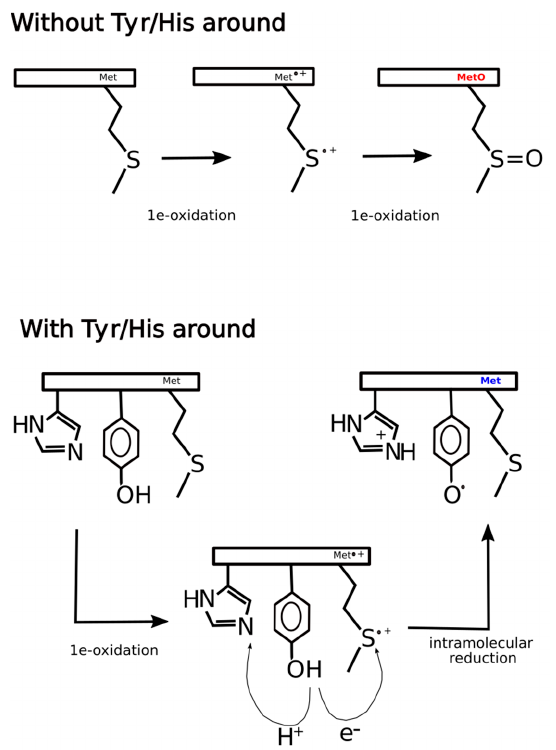
Figure 11. Hypothetical mechanism of ex vivo methionine oxidation. In the absence of tyrosine and histidine in the neighborhood of a given methionine residue, two consecutive one-electron oxidations lead to the formation of methionine sulfoxide. However, if tyrosine and histidine are present in the environment of the methionine site, after the first one-electron oxidation, the intermediate sulfur radical cation can be reduced back to methionine through an intramolecular redox reaction where tyrosine acts as a reducing agent leaving behind a tyrosyl radical. As tyrosine oxidation implicates a concerted deprotonation/oxidation of the hydroxyl group, the transfer of a proton to a nearby proton-accepting histidine residue may facilitate the global reaction.